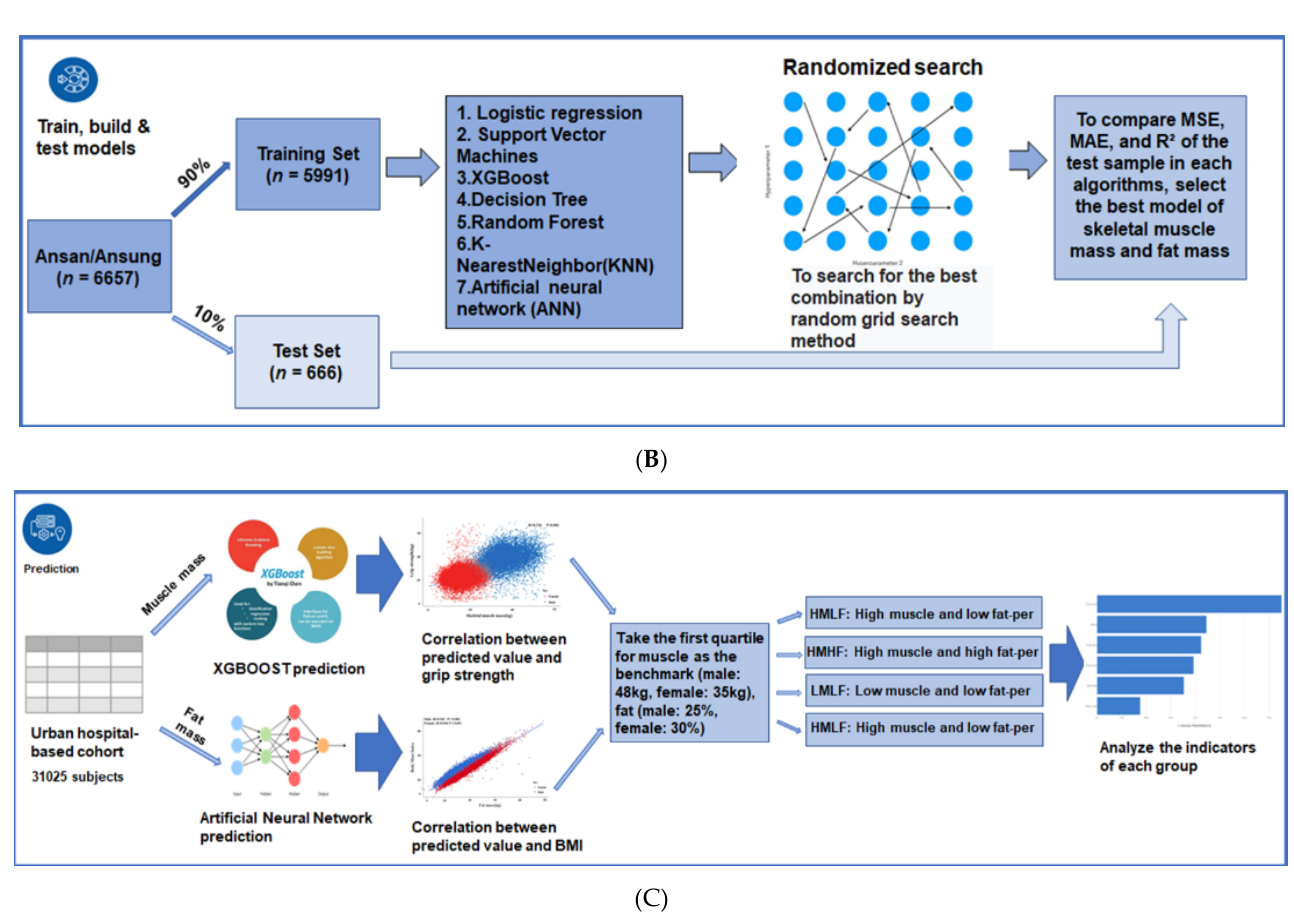
Figure 1. Experimental flowchart. ( A ) Flow to filter features for SMM and FM in Ansan/Ansung cohort. ( B ) Flow to generate the best model by a random grid model in the training set and checking the error in the test set. ( C ) Flow to analyze clinical characteristics of the participants with high or low skeletal muscle mass (SMM) and fat mass (FM) of the urban hospital-based cohort.